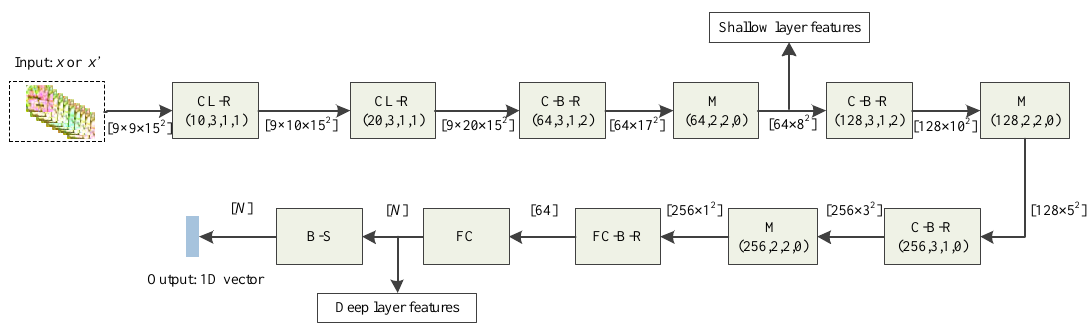
Figure 4. The network architecture of proposed method. Acronyms are, as follows: CL: ConvLSTM, C: Convolutional, R: ReLU, B: Batch Normalization, M: Max pooling, FC: fully connected, S: Softmax. The numbers in parentheses are filter kernels, kernel size, stride, and padding. The numbers in square brackets are the sizes of feature maps and N denotes the number of